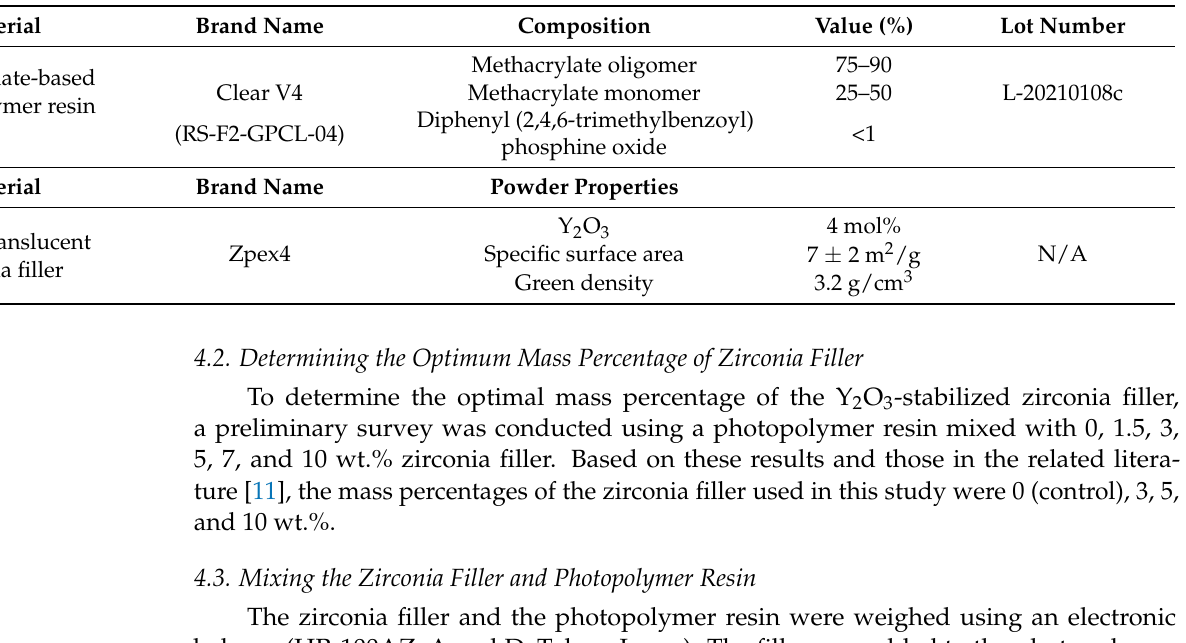
Table 5. Details of the tested